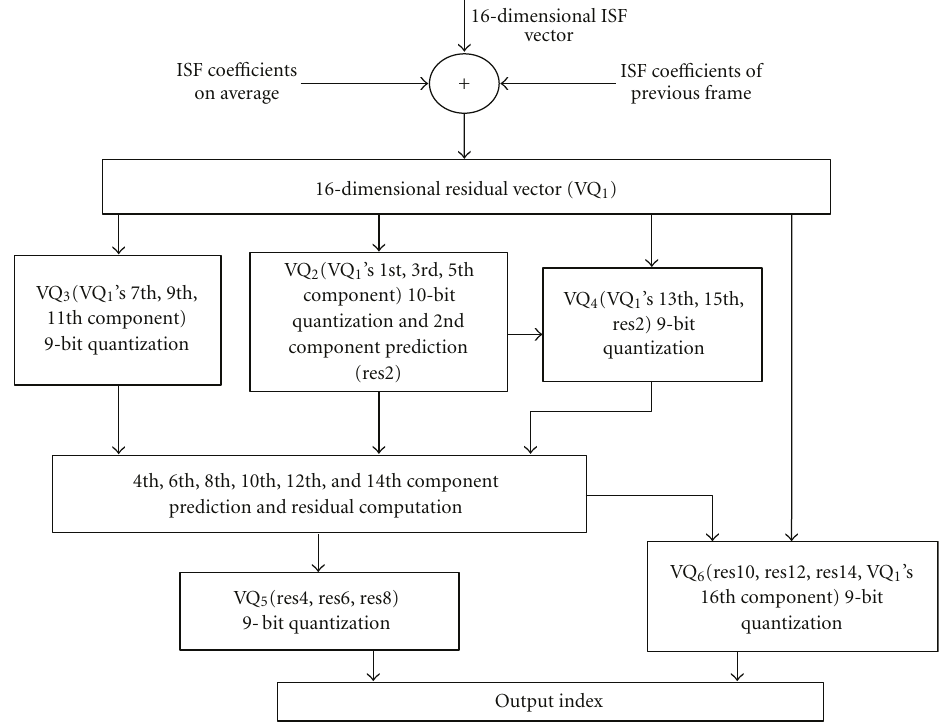
Figure 5: AVS-M audio ISF vector